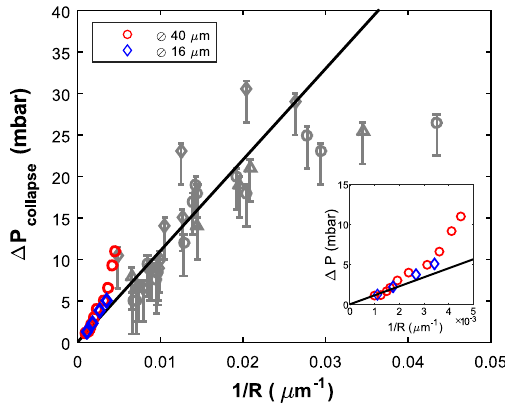
FIG. 8. Armored bubble collapse pressure as a function of the inverse radius. The black line is our model prediction, the gray symbols correspond to our experimental points, and the colored symbols correspond to measurements from Ref. [17] for two different particle diameters: 16 μ m and 40 μ m. The inset is a close-up for small values of 1 =R